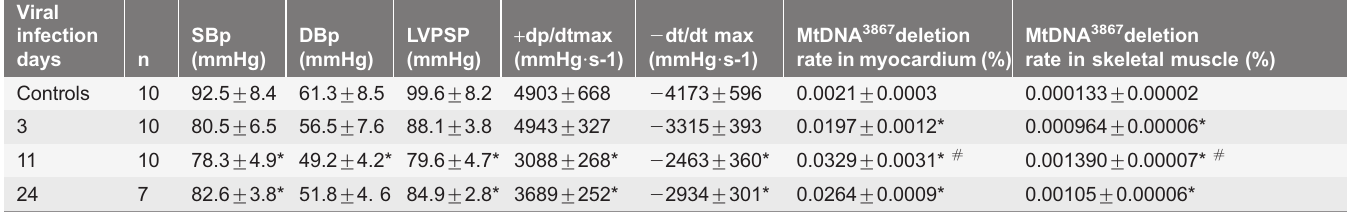
Table 3. Heart function, and MtDNA 3867 deletion rate in myocardium and skeletal muscle of VMC mice (mean ¡ SEM). Viral